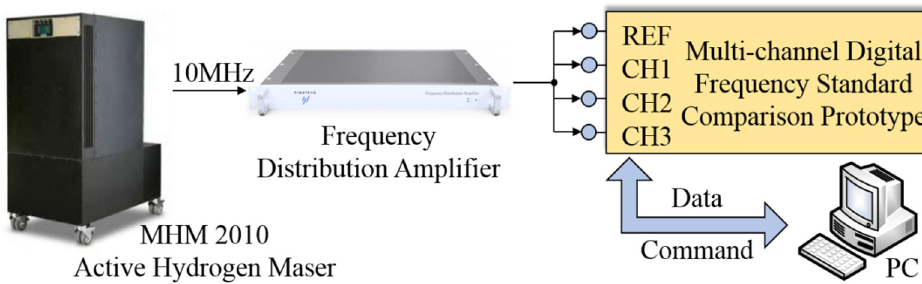
Figure 7. A diagram of the experimental test platform.